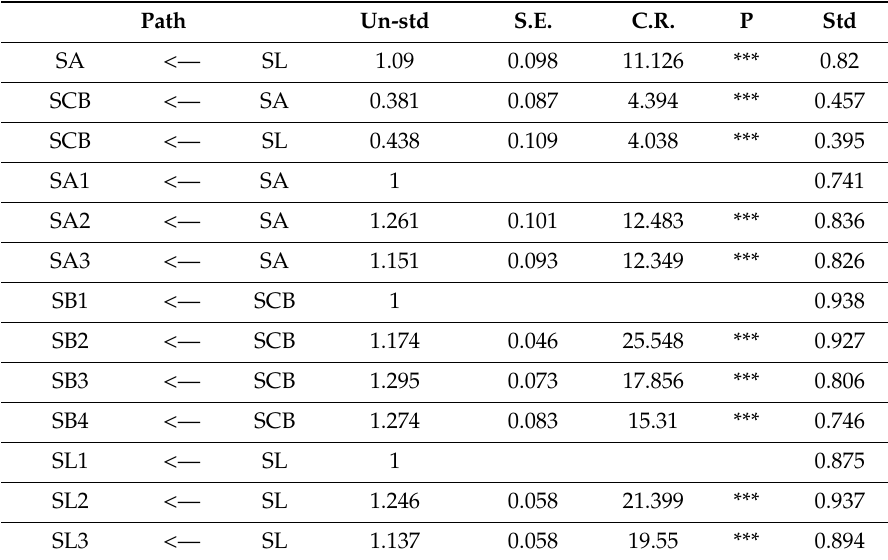
Figure 3. Structural equation model of safety leadership, safety attitude and safety citizenship behavior. SL is safety leadership; SA is safety attitude; SCB is safety citizenship behavior. SL1 is leadership behavior; SL2 is safety concerns; SL3 is security control; SA1 is safety awareness; SA2 is safety behavior tendency; SA3 is safety emotion; SB1 is mutual aid among workers; SB2 is relationship between superior and subordinate; SB3 is participation in suggestion-making; SB4 is self-control. e1 to e12 are residuals describing the part of an endogenous variable that cannot be explained. Values on the paths are the standardized path coe ffi cients. Values next to rectangles and latent variables represent the variance the factor accounted for in the model. Table 6. Path coefficient and significance of SEM (structural equation model).